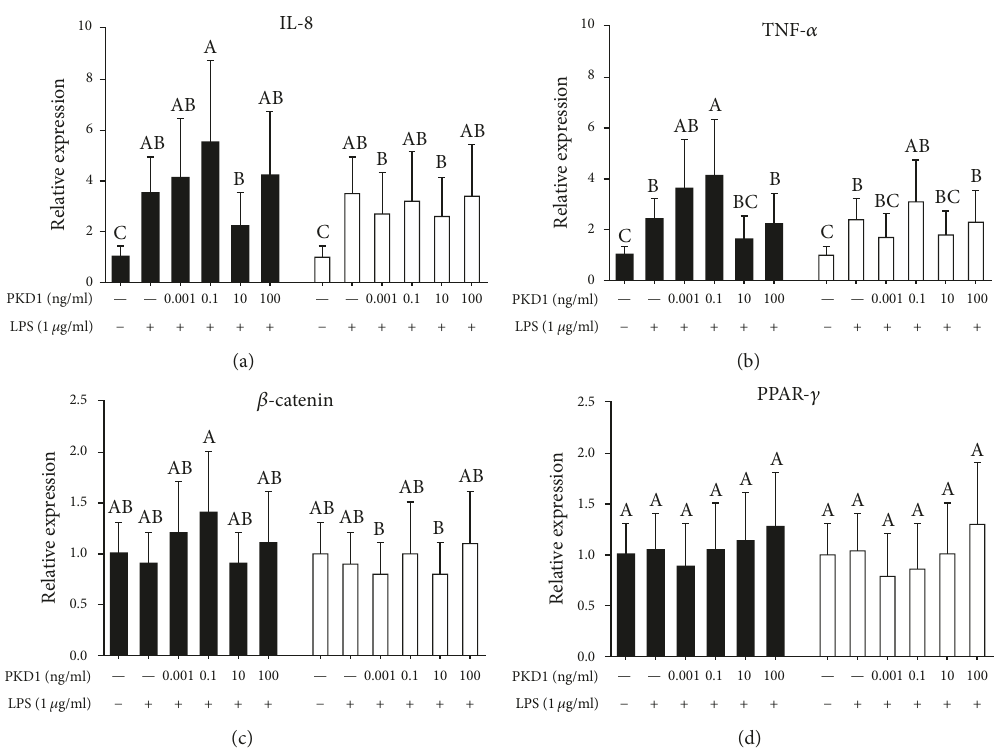
Figure 4: Effect of PKD1 on IL-8, TNF- 𝛼 , 𝛽 -catenin, and PPAR- 𝛾 mRNA expression in Caco-2 cells. Protein kinase D1 (PKD1; 0.001, 0.1, 10, 100 ng/ml) was administered apically to Caco-2 cells in co-culture with RAW264.7 cells. An inflammatory response was induced in RAW264.7 cells with 1 𝜇 g/ml lipopolysaccharide (LPS, E. coli : O127). Effects of PKD1 on IL-8, TNF- 𝛼 , 𝛽 -catenin, and PPAR- 𝛾 expression levels were evaluated in two different situations: ( ◼ ) LPS was administered to RAW264.7 cells for 3h, followed by PKD1 to Caco-2 cells for 3 h to investigate whether PKD1 can ameliorate an already established inflammation. ( ◻ ) PKD1 was administered to Caco-2 cells for 3h at which point RAW264.7 cells were stimulated with LPS for 6h to evaluate whether PKD1 can suppress inflammation initiation. Data are presented as mean transcriptional levels relative to the negative control (0% FCS, unstimulated) with 95% confidence intervals ( 𝑛 = 3 ). Significant differences ( 𝑃 < 0.05 ) within concentrations of PKD1 and LPS are indicated by the uppercase